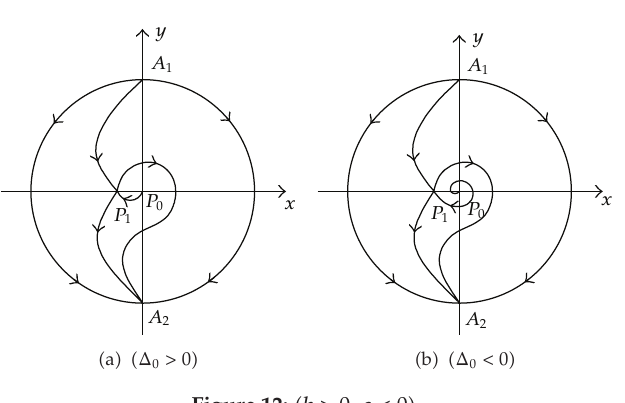
Figure 12: (cid:6) b > 0, c < 0 (cid:7)